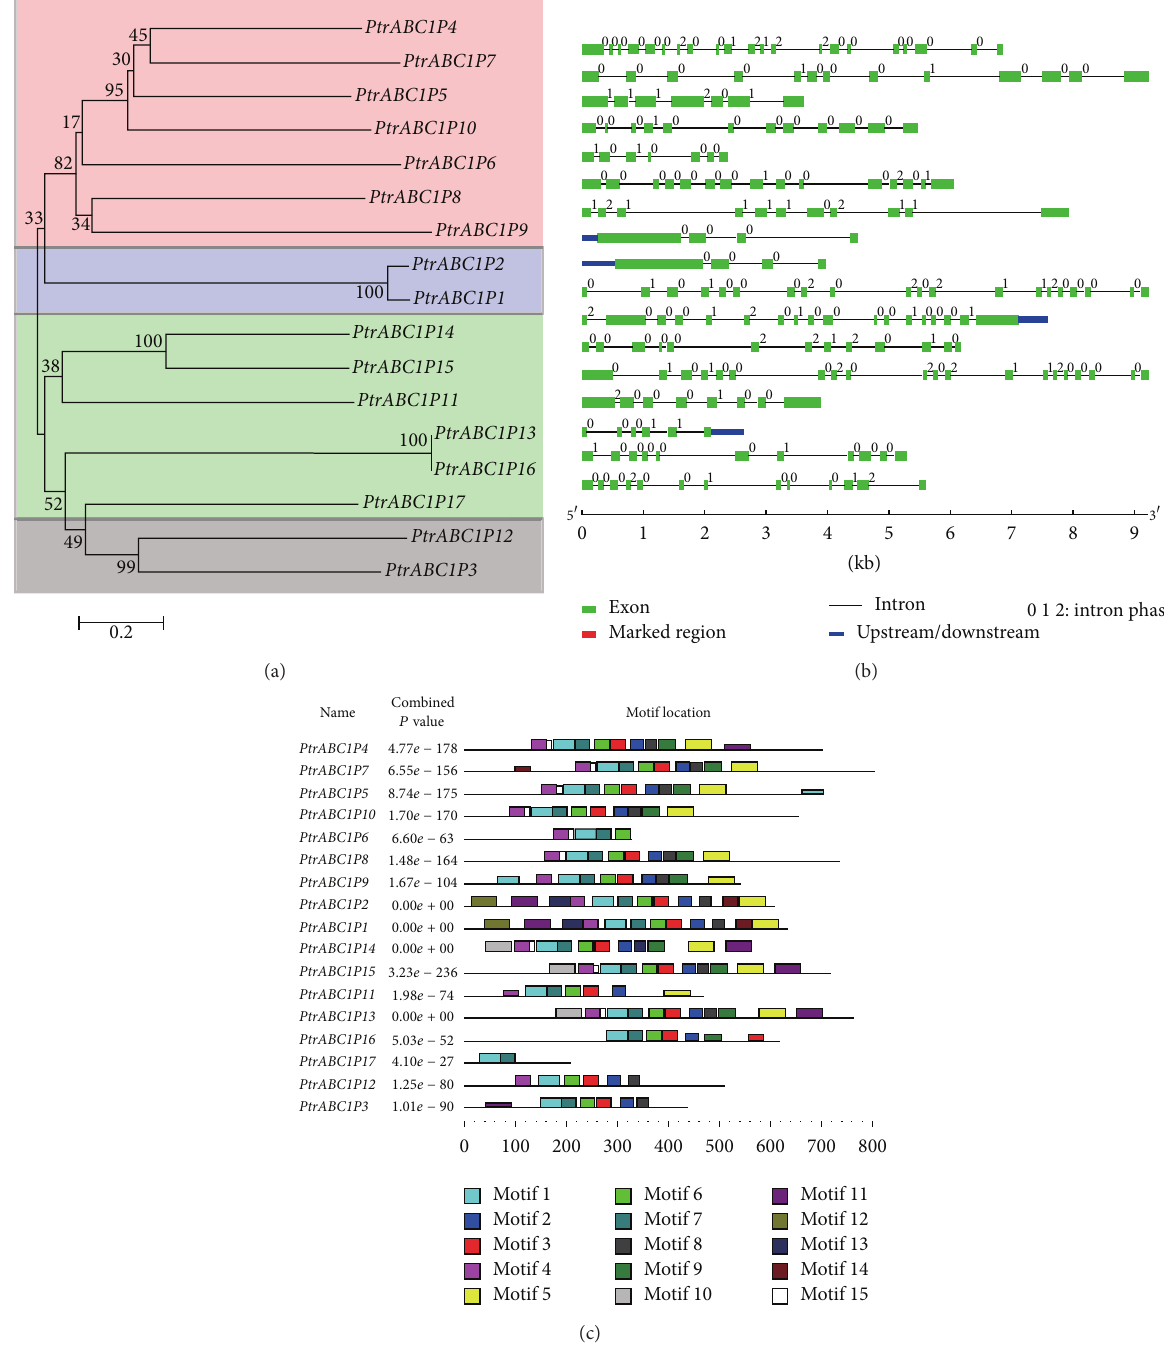
Figure 4: Phylogenetic analysis of the 17 P. trichocarpa ABC1 genes (a) with the integration of exon/intron structures (b) and motifs (c). Exon/intron structures were obtained from the Gene Structure Display Server. Motifs were investigated using the Multiple Expectation Maximization for Motif Elucidation (MEME)